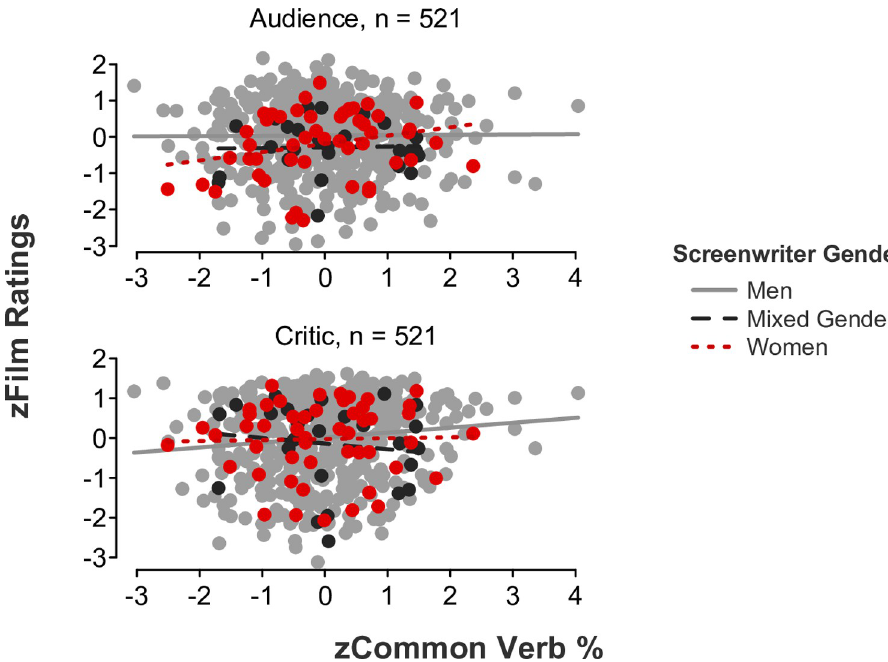
Fig 3. Film ratings as a function of common verb use, screenwriter gender, and rater role.